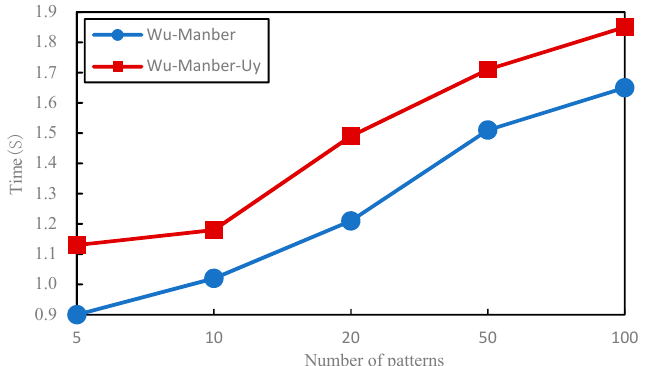
Figure 11. Comparison of time performance.